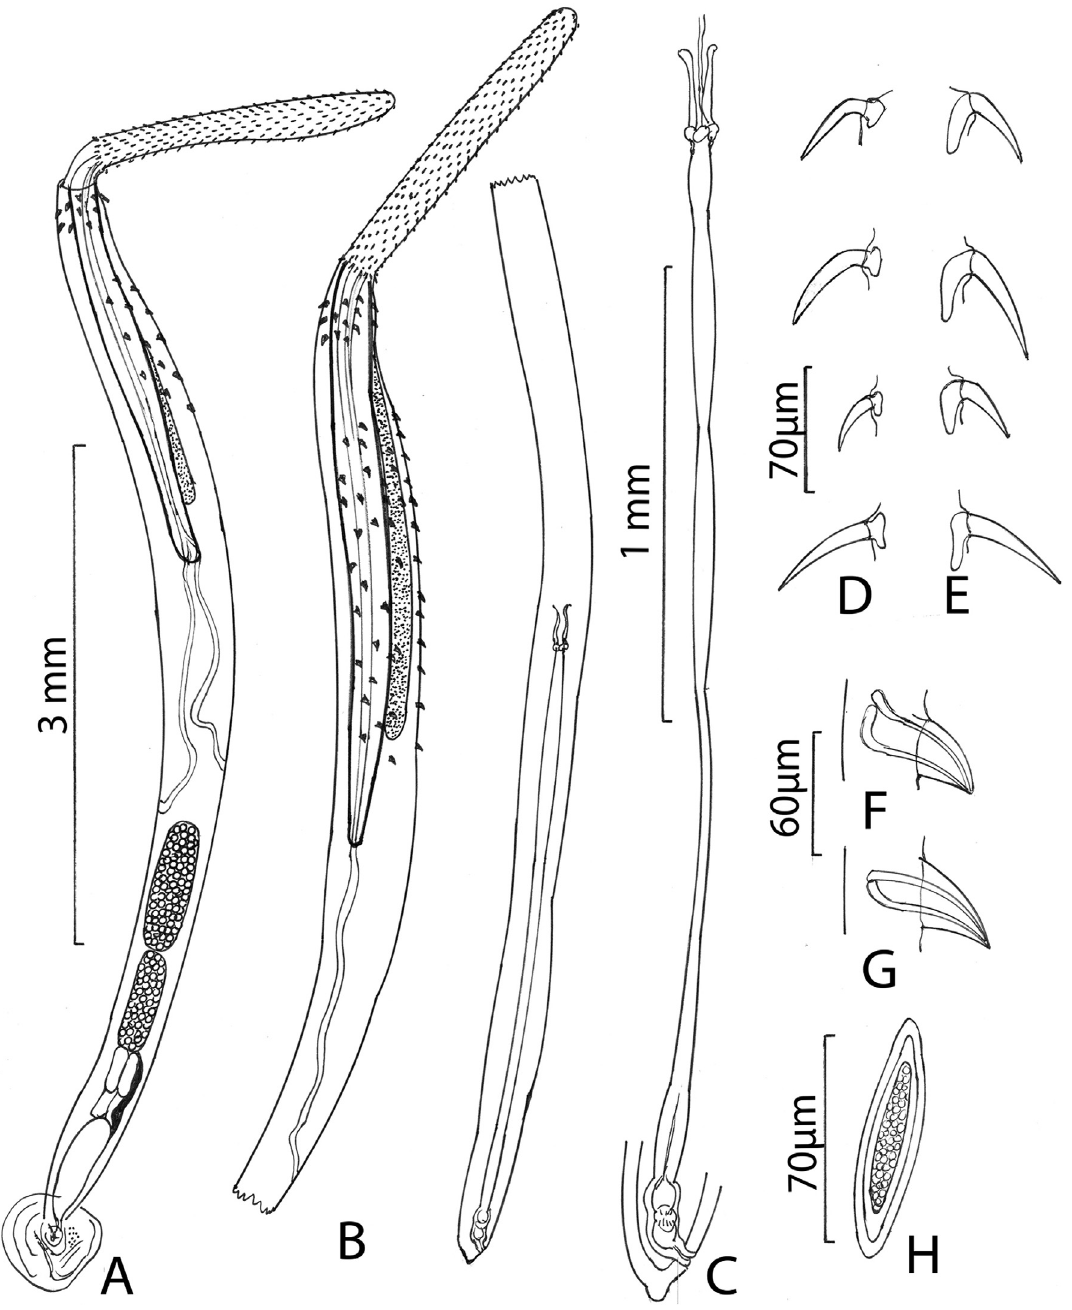
Figure 1. Line drawings of specimens of Rhadinorhynchus oligospinosus from the mackerels Scomber japonicus and Trachurus murphyi from off the Pacific coast of Peru. Normal body wall thickness (A, B) not shown. (A) Holotype male. Note the lemniscus being shorter than the receptacle, the restricted distribution of posterior trunk spines, and posterior position of the reproductive system. The common sperm duct is lateral and ventral to the four cement glands. (B) Allotype female with the same distribution of lemniscus and posterior trunk spines as in the male. Measurement scale is the same as the male (A). (C) Detail of the long female reproductive system of specimens in (B); note the simple uterine bell and glands. (D) Apical, middle, posteriormost, and basal dorsal proboscis hooks in a male specimen. (E) Apical, middle, posteriormost, and basal ventral proboscis hooks in the same male specimen. Note the dorso-ventral diversification of hooks and the reduced dorsal hook roots. (F) A profile of a ventral anterior trunk spine in a female specimen. (G) A profile of a ventral posterior trunk spine in the same female specimen. (H) A ripe